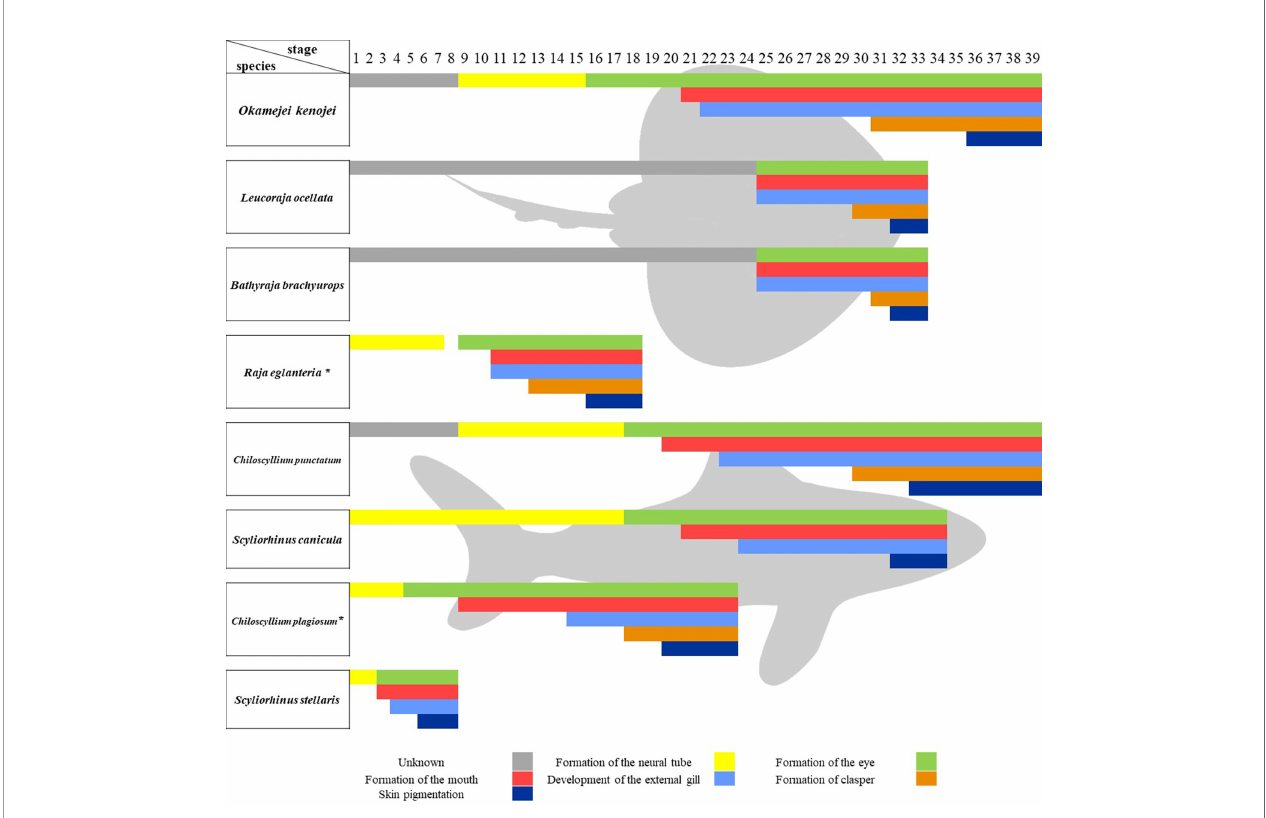
FIGURE 8 | Comparison of embryonic development timeline in sharks and skates. Comparison of the main developmental events in developing sharks and skates. *stages are divided according to the development time and pictures in the